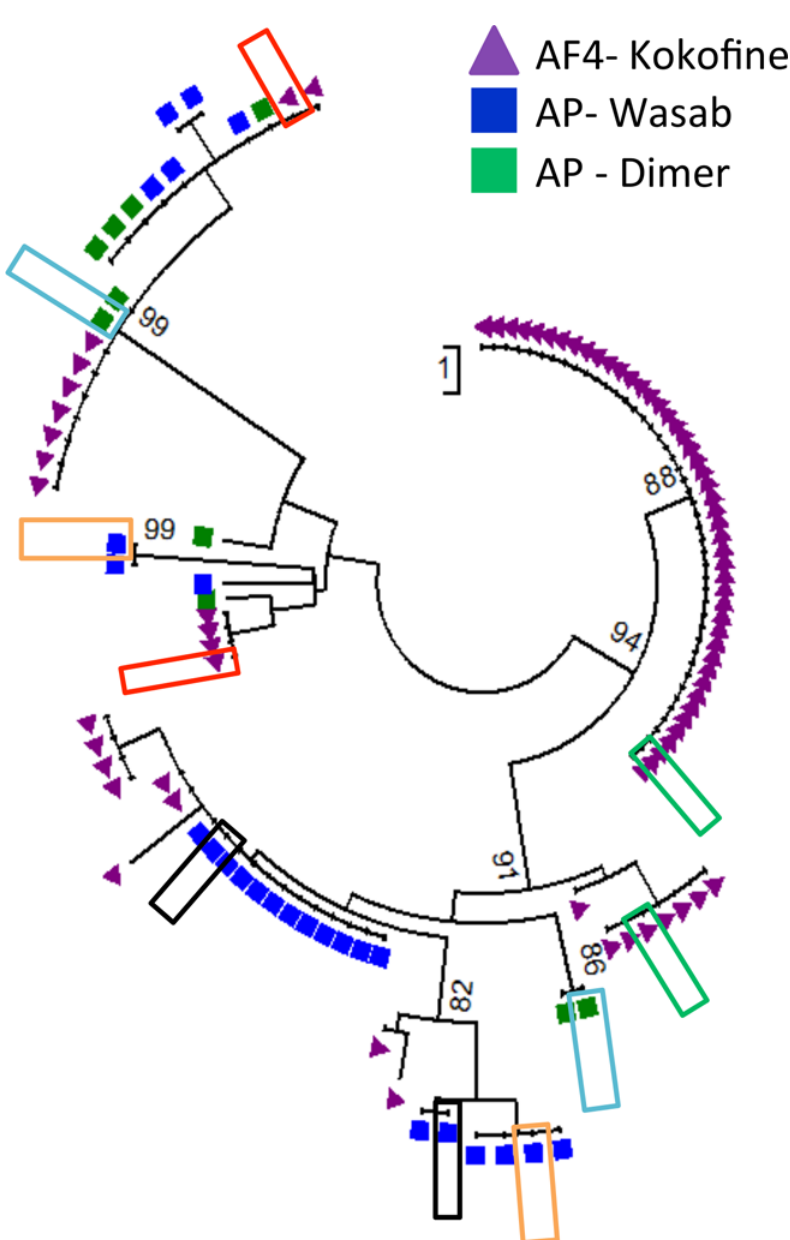
Fig 3. Neighbor-joining tree showing the relationships among the human mtDNA haplotypes amplified from mosquitoes. Each symbol represents one DNA sequence amplified from one mosquito. Different shapes represent different Anopheles species (squares- An . punctulatus s . s ., triangles- An . farauti 4) and is colored according to the collection site (green-Dimer, blue-Wasab, purple-Kokofine). Mixed blood meals are highlighted by boxes of the same color: for example, the two red boxes show two human mtDNA haplotypes amplified from a single An . farauti 4 mosquito collected in